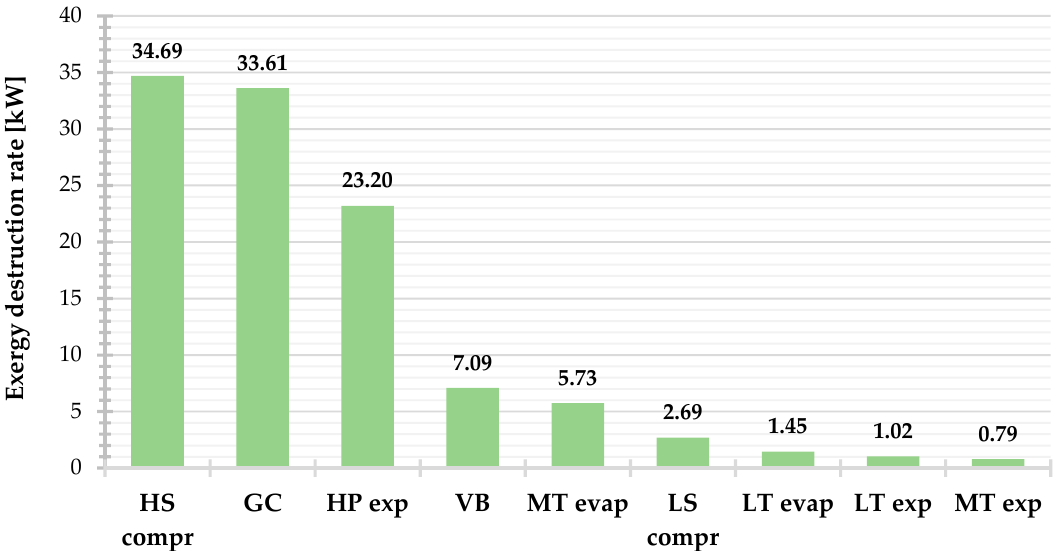
Figure 3. Exergy destruction rates of the components belonging to CB at the outdoor temperature of 40 °C.